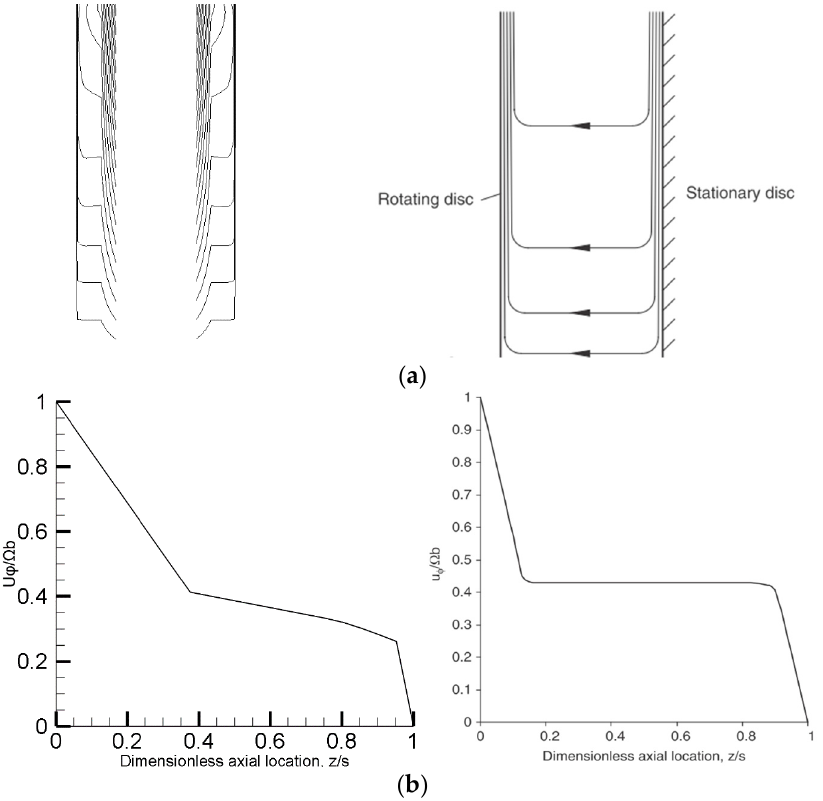
Figure 10. Flow streamlines for a cross sections of the reactor wheelspace and normalized axial tangential velocity profiles on X-Z plane at N = 70 rpm: ( a ) cross sections of the CFD and Batchelor models; ( b ) tangential velocity profile of the CFD and Batchelor models at y = 0.068 [8].